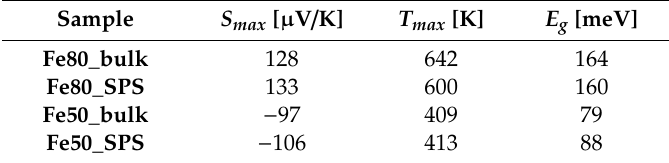
Table 3. The maximum value of the Seebeck coe ffi cient ( S max ), the temperature corresponding to S max ( T max ), and the value of the energy gap ( E g ) estimated through Equation (4) for samples Fe80 and Fe50.